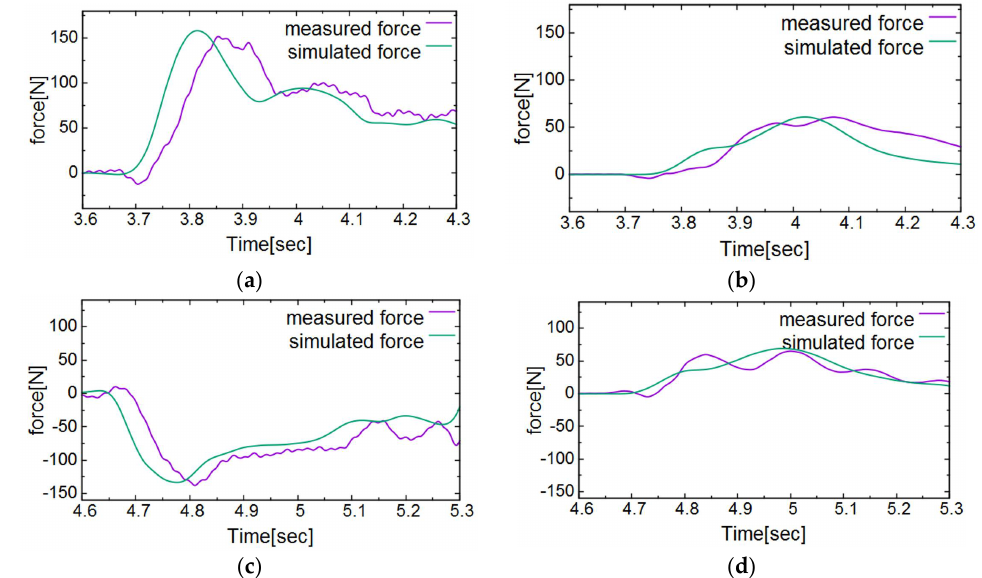
Figure 7. The measured and simulated forces acting on the fin: ( a ) Horizontal force when the fin moved in + Z direction; ( b ) Vertical force when the fin moved + Z direction; ( c ) Horizontal force when the fin moved in − Z direction; ( d ) Vertical force when the fin moved in − Z